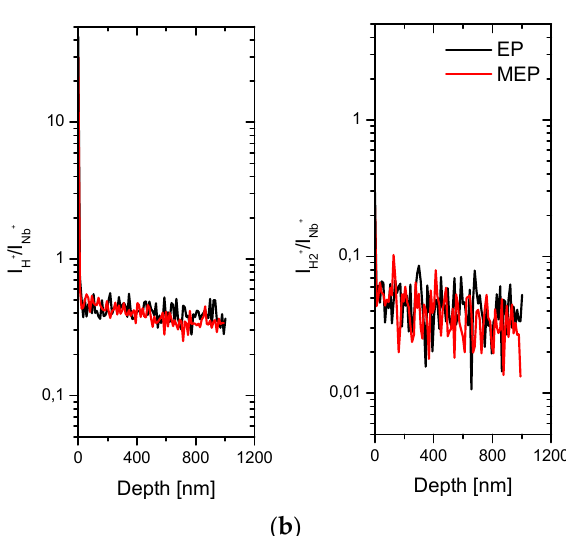
Figure 6 . Dependence of ratio of secondary ion currents for positive hydrogen (H + and H 2+ ) to secondary ion currents of niobium on time of the ion etching. Time of ion etching: 5000 s ( a ), the depth of etched niobium layer equals to 1 micrometer ( b ).